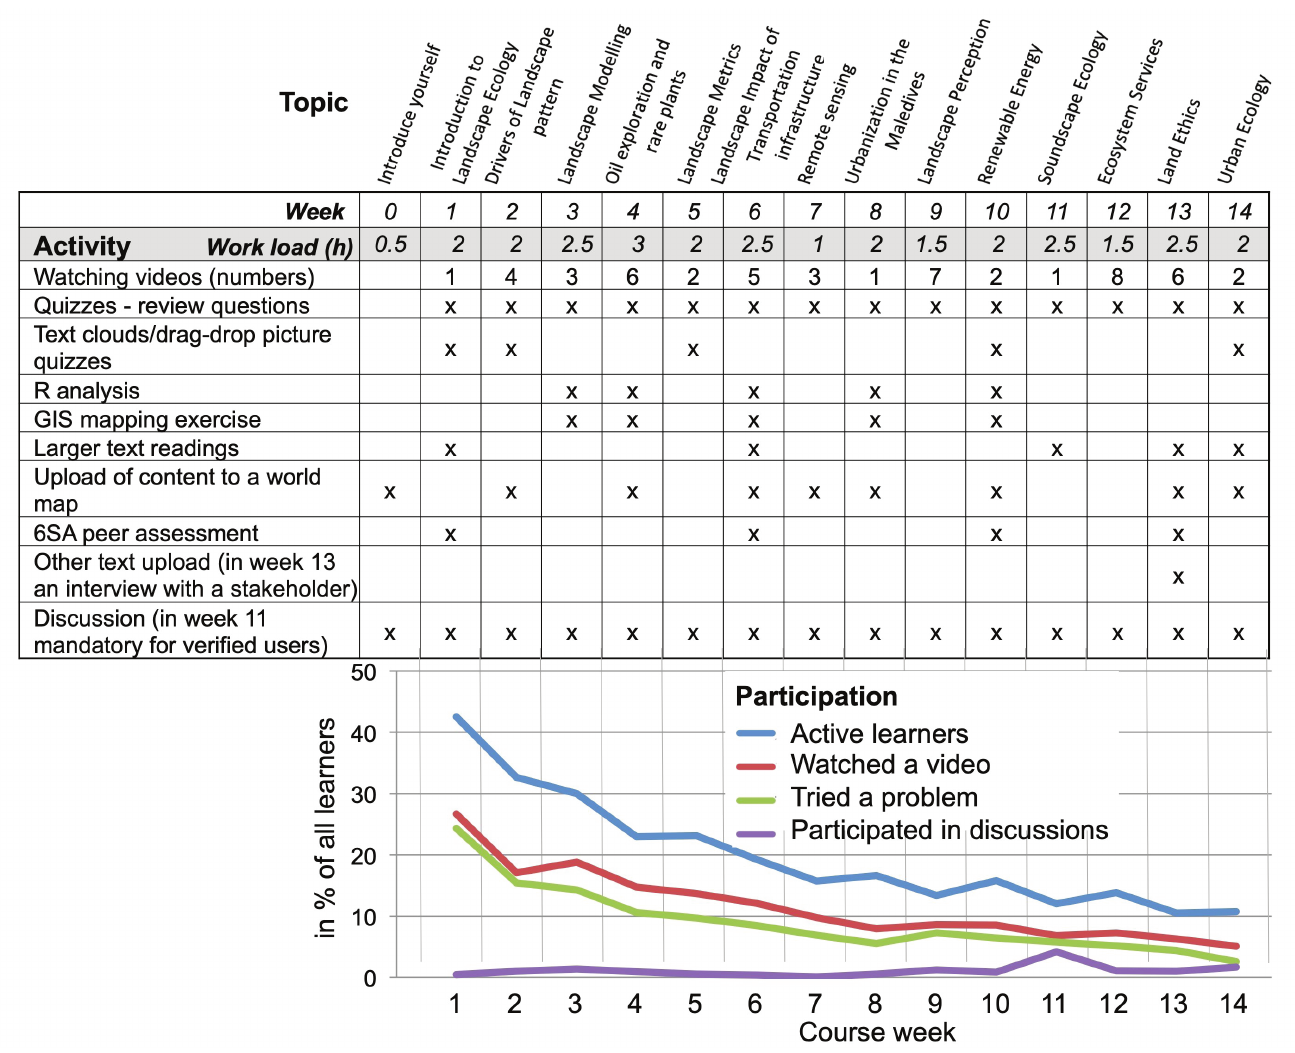
Figure 4: Activity/performance profile of the 2019 MOOC on Landscape Ecology. The upper part of the Figure yields information on didactic elements and tools of the course (videos, quizzes, map uploads etc.) and how they are distributed in the different units, each column represents one week. The lower part of the Figure shows how active students were over time (“active learners”, “watched a video” etc.), where each point in the curve represents one week. Numbers are given in percent of all learners. The category “active learners” is not additive, i.e. a student that tries a problem and watches a video is counted as 1 active